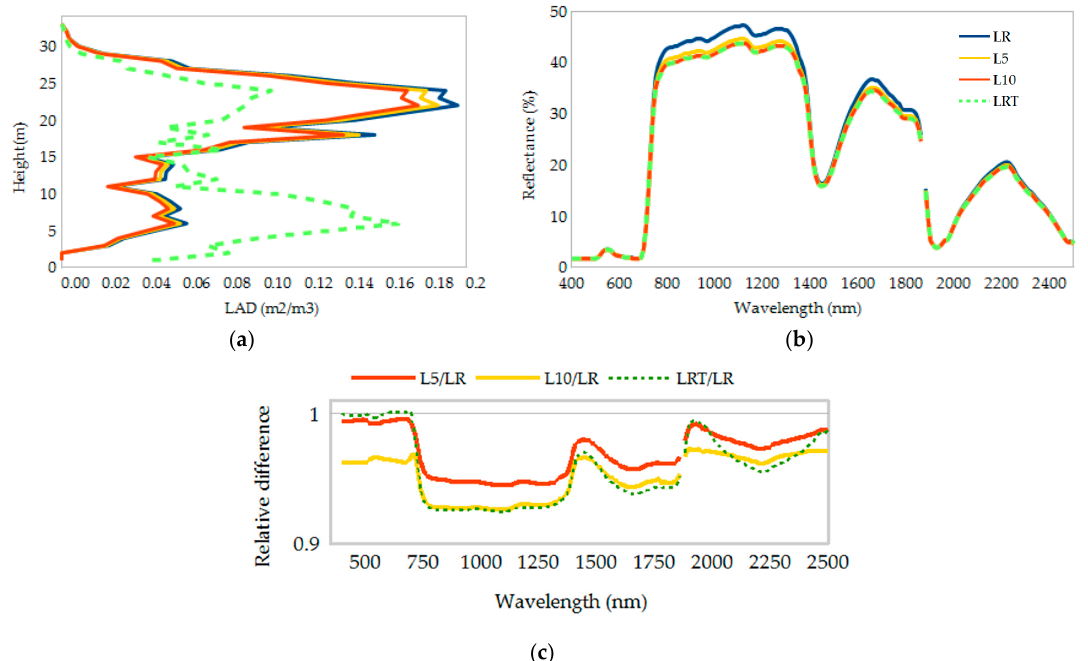
Figure 3. ( a ) Vertical profiles of leaf area density (LAD) for the simulated forest canopy with reference leaf area index (LR: 2.32 m 2 /m 2 ), LR reduced by 5% and 10% (L5: 2.22 m 2 /m 2 and L10: 2.09 m 2 /m 2 , respectively), and LR with modified LAD distribution (LRT: 2.32 m 2 /m 2 ); Measured spectra from simulated canopies expressed as reflectance ( b ) and relative difference to LR ( c ).